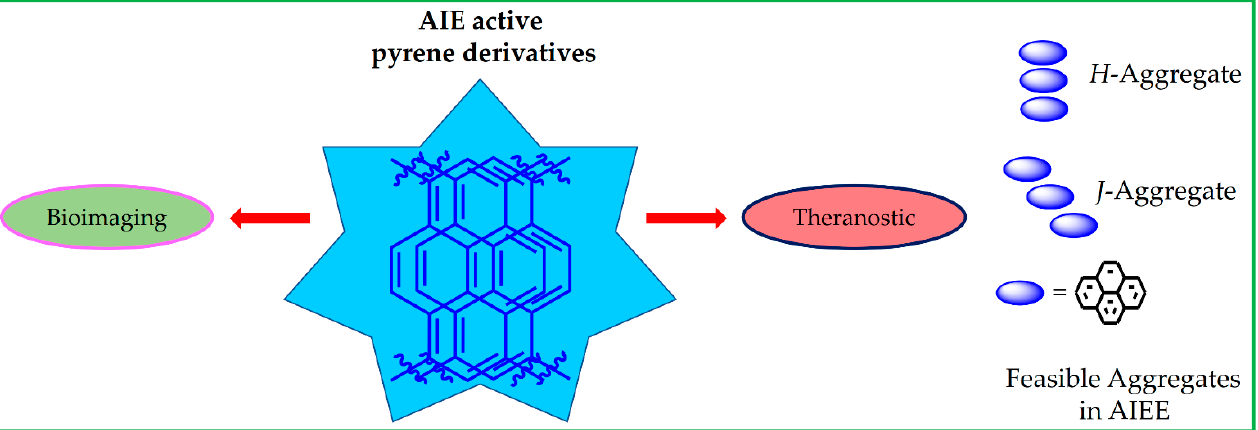
Figure 1. Schematic of AIE-active pyrene derivatives towards bioimaging and theranostics applica- tions and representations of feasible H - or J